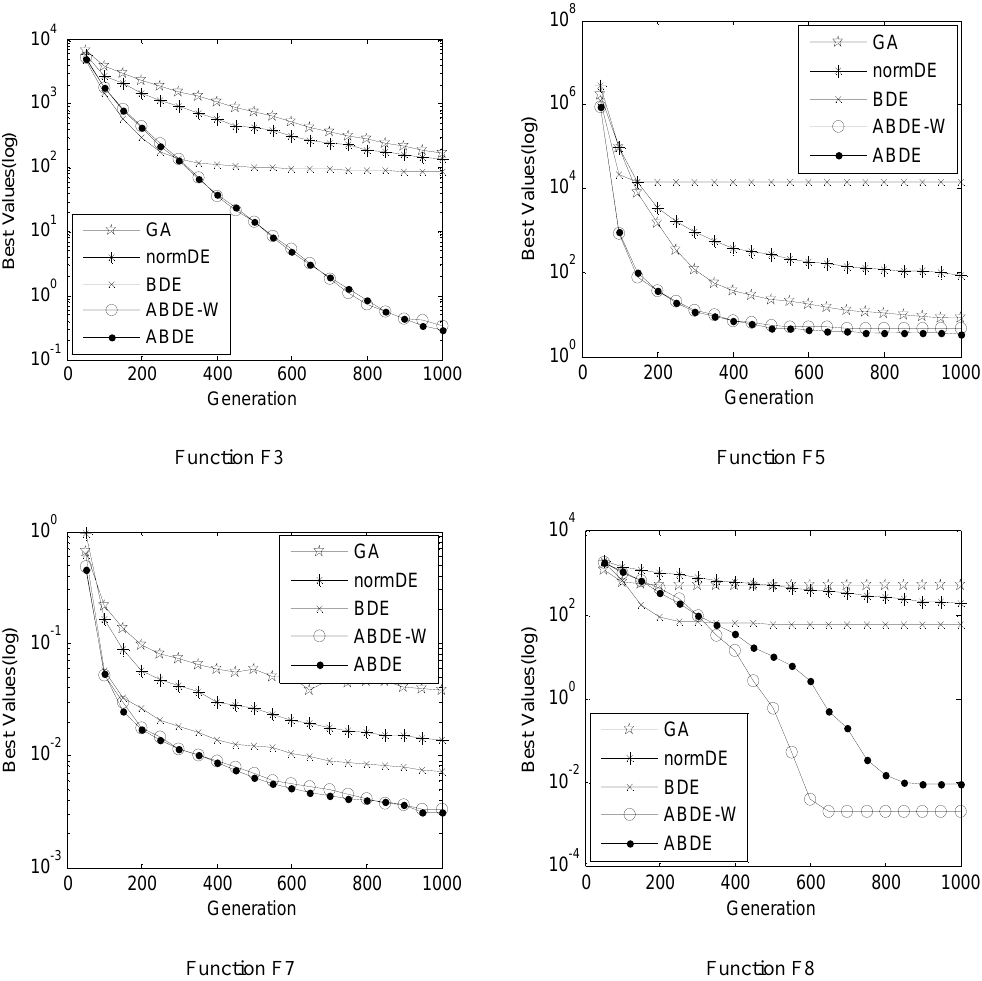
Fig. 3 Convergence performance of the proposed algorithm